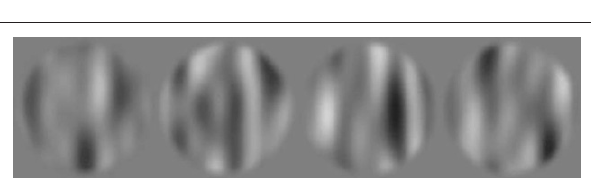
FIGURE 5 | Example of a vertical stimulus presented in the fractal control condition. A sequence of four presented frames on a single interval is shown. Noise is resampled on every presented frame. As can be seen, a flickering pattern is